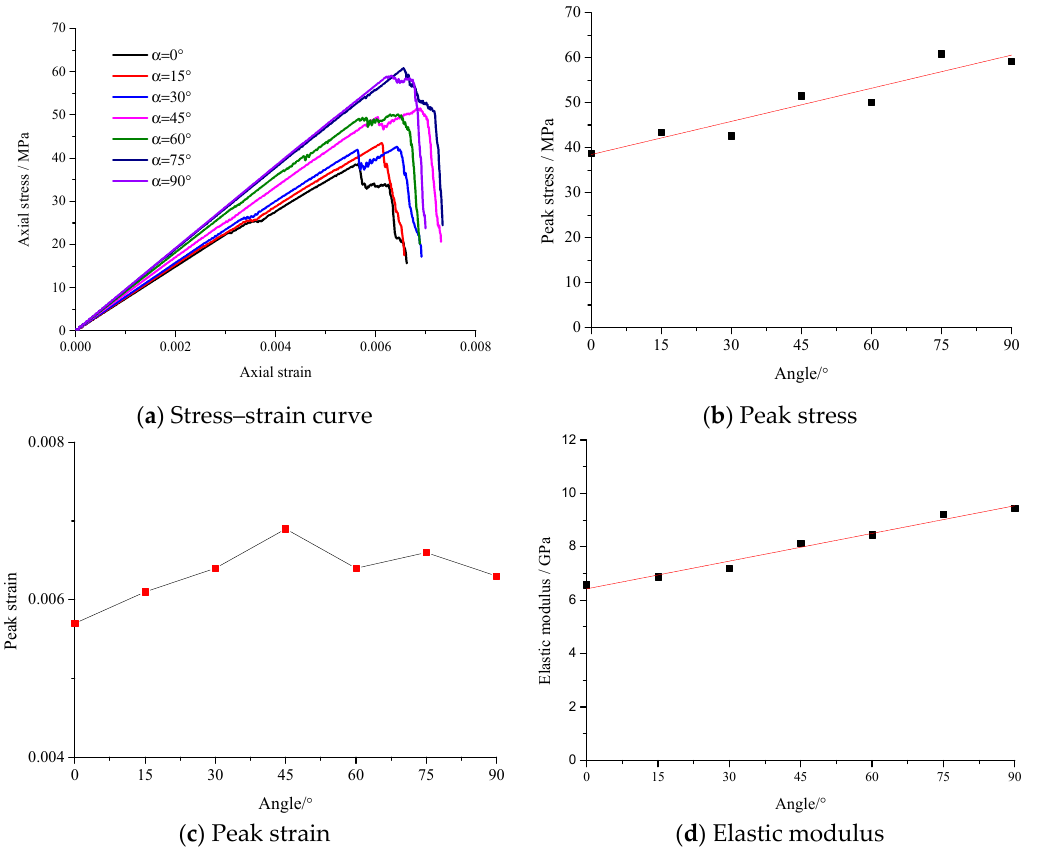
Figure 6. Mechanical properties of different crack angle models. The mechanical parameters of numerical simulation of defect combination model with different fracture angles under uniaxial compression are shown in Table 4. In the seven defect combination models, the maximum peak stress occurs in the 75 ◦ model, which is 60.84 MPa, the maximum peak strain occurs in the 45 ◦ model, with the minimum value of peak strain being 0.0069, and the maximum value of elastic modulus occurs in the 90 ◦ model, which is 9.44 GPa. Compared with intact rock, the peak stress, peak strain, and elastic modulus of each defect combination model are smaller than those of intact